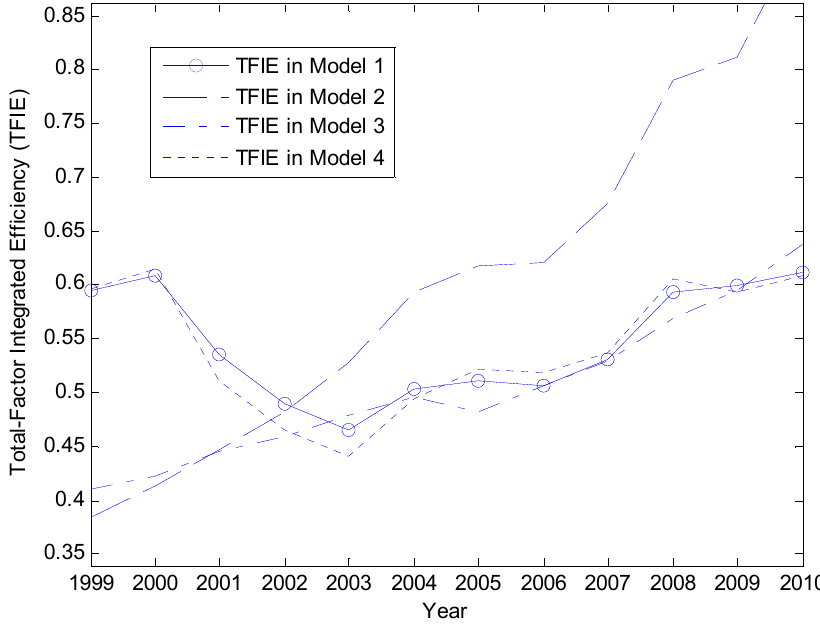
Figure 5. Total-factor integrated efficiency (TFIE) estimated by four